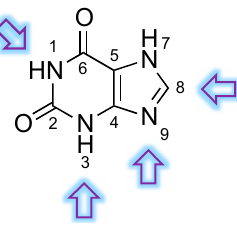
Figure 9. General structure of the xanthine scaffold. The positions that were modified in the abovementioned study have been marked with an arrow.